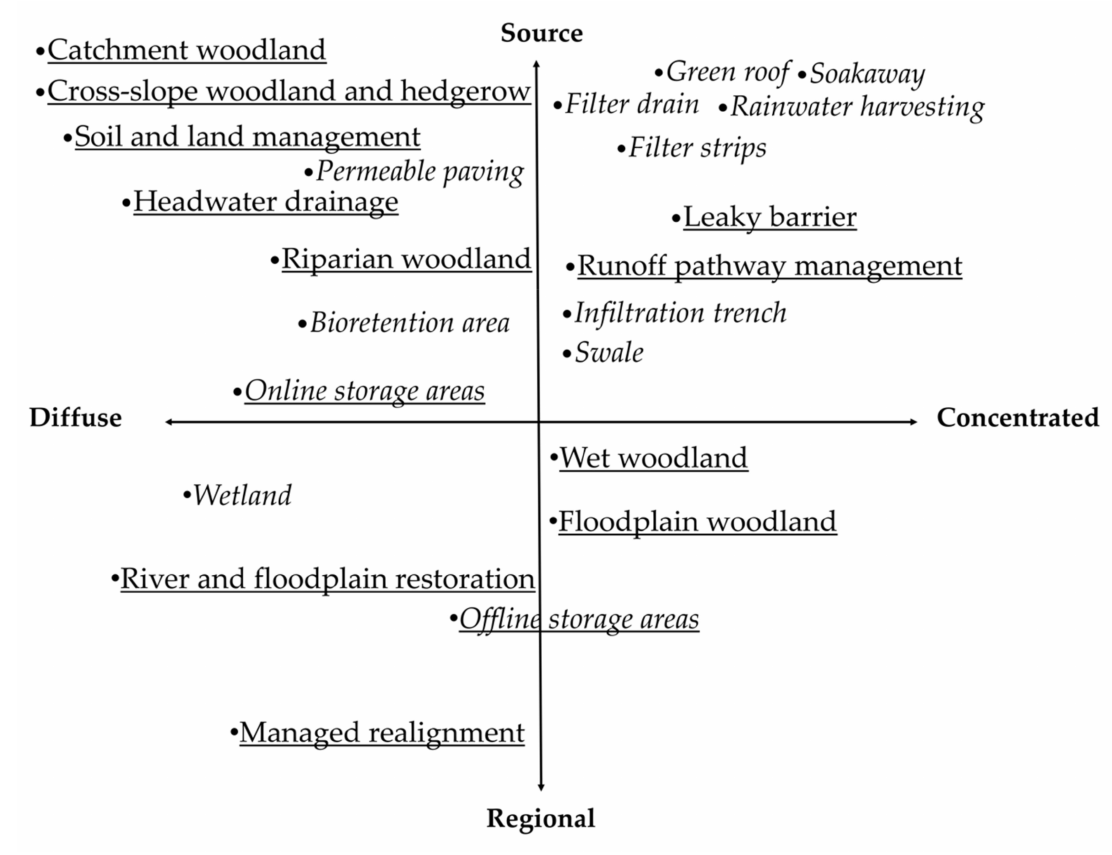
Figure 1. Outline of NFM and SuDS techniques from source to regional scale, which typically manage flood flows at a diffuse or concentrated scale. The dot denotes the position on the scale. Underlined techniques are considered NFM. Italicised techniques are considered SuDS. Techniques that are underlined and italicised are considered as both NFM and